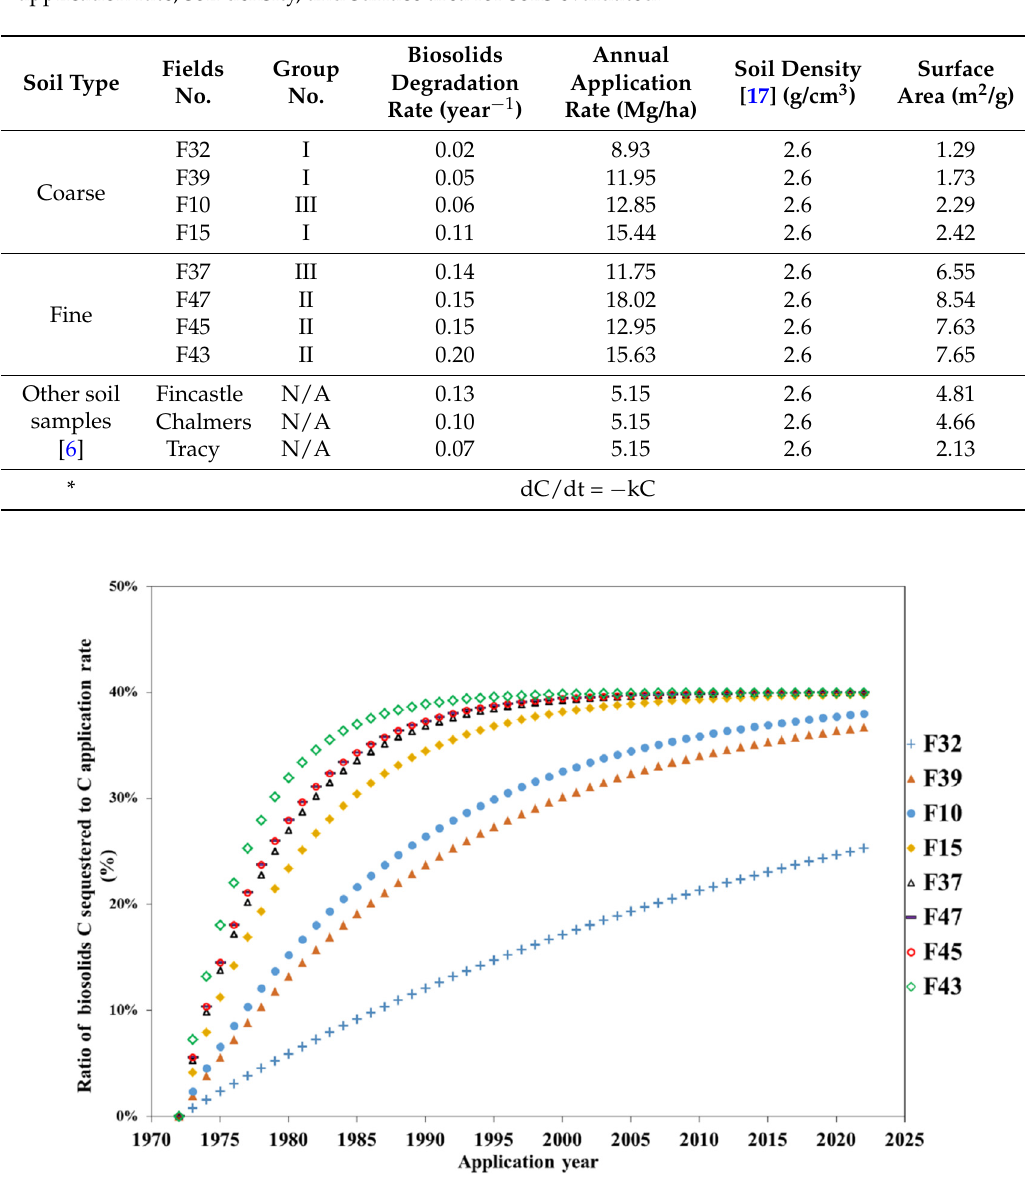
Figure 2. Percent of biosolids converted to biomass (carbon sequestration) between 1972 and 2025 for the eight fields. The variation between fields is due to difference in the degradation rate (See Table1).